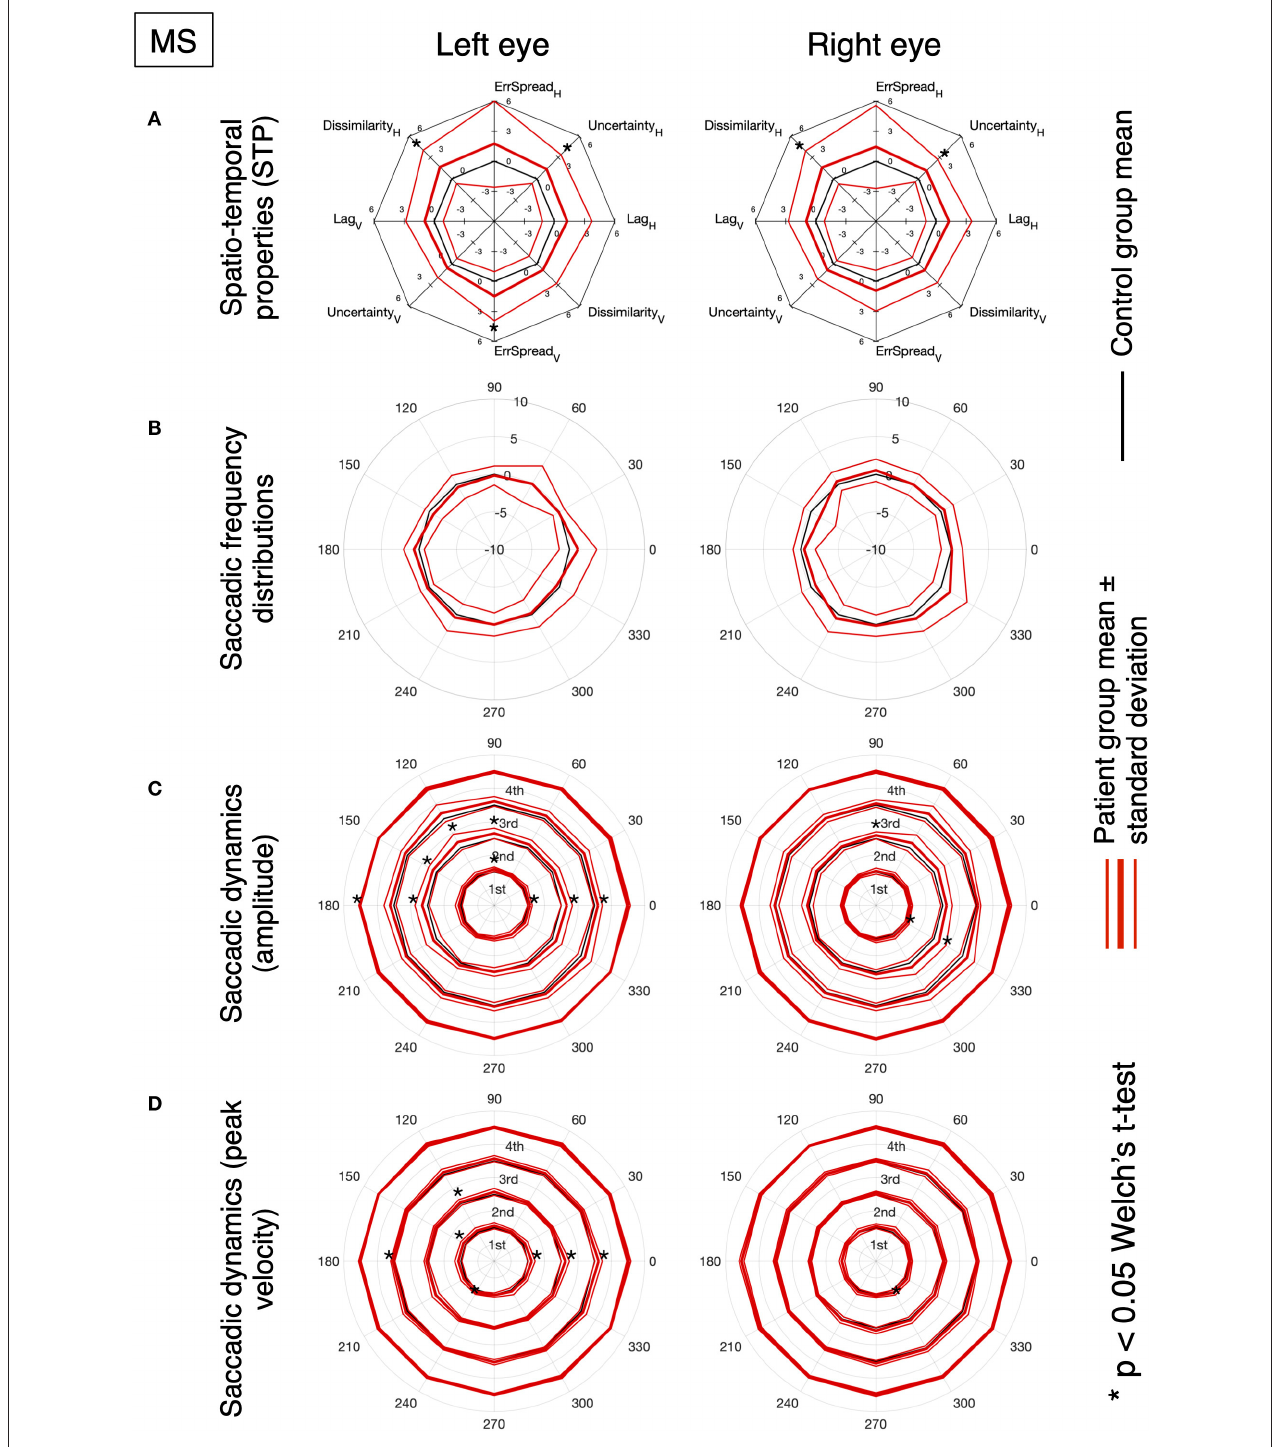
FIGURE 5 | (A) MS and PD group analysis of normalized spatio-temporal properties. (B) Normalized saccadic frequency distribution as a function of direction. (C) Normalized saccadic amplitude as a function of direction. (D) Normalized saccadic peak velocity as a function of direction. The results of the saccadic dynamics are stratified per quartile. An asterisk indicates a significant difference between normative values obtained from the control group.